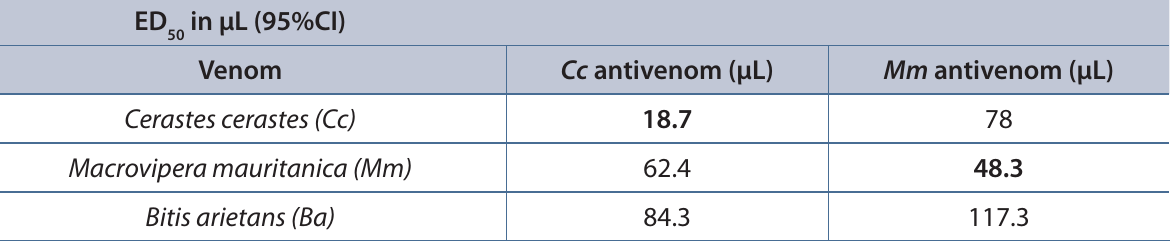
Table 1. Determination of neutralizing effective doses (ED50) of Cc and Mm antivenoms in